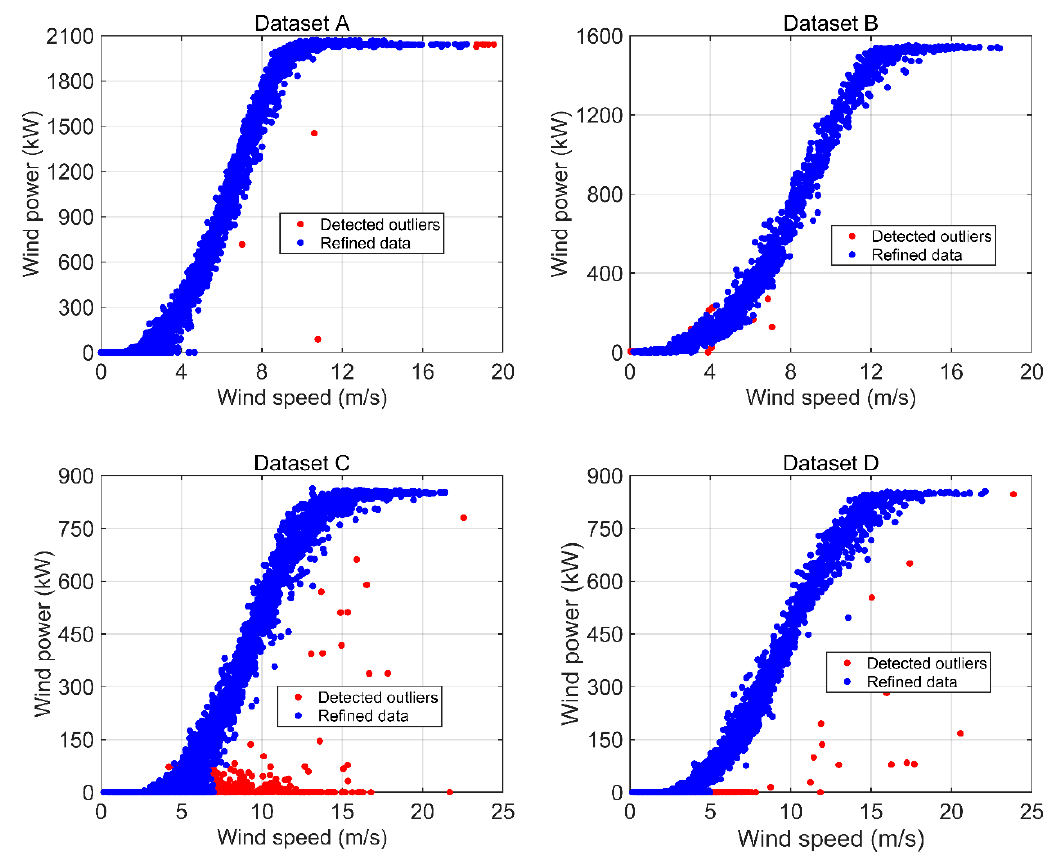
Figure 3. Different kinds of data in four datasets. Figure 3. Di ff erent kinds of data in four